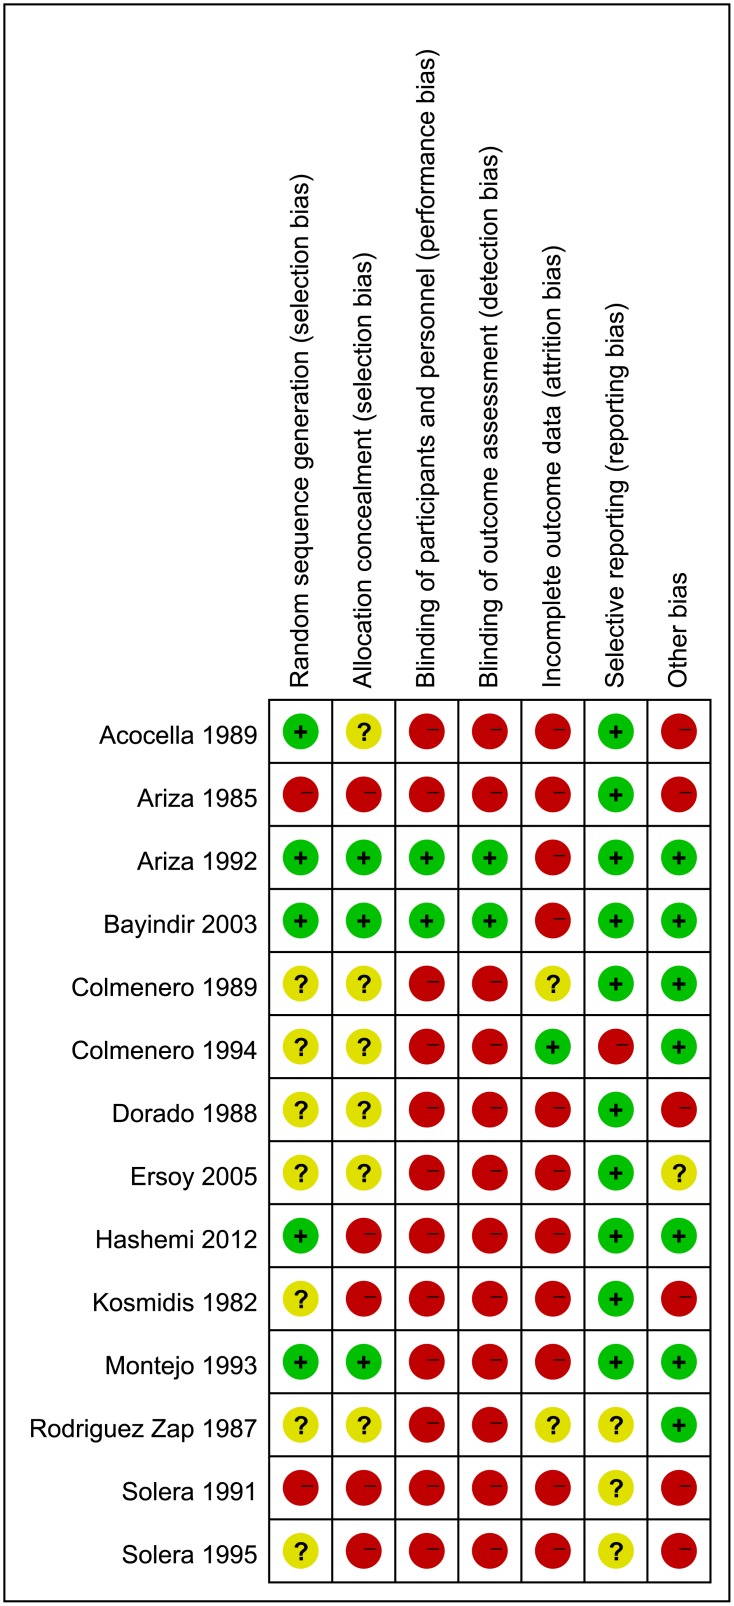
Risk of bias summary of included RCTs.